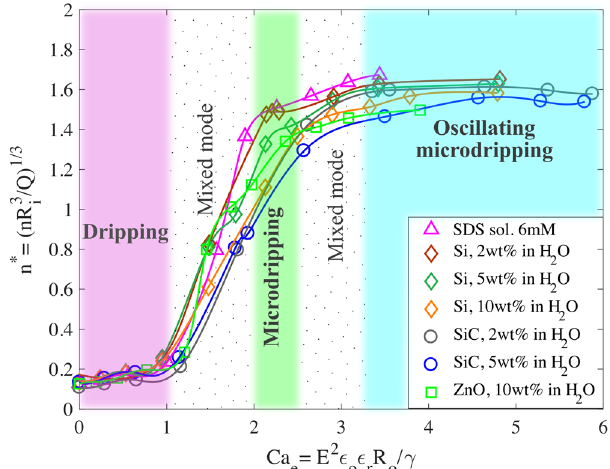
Figure 6. Dimensionless meniscus frequency vs electric capillary number. The frequency changes abruptly at the transition between dripping and microdripping mode. Fluids with high capillary number tend to have lower frequency at a given electric capillary number due to viscous effects. The modes are color coded corresponding to Fig.